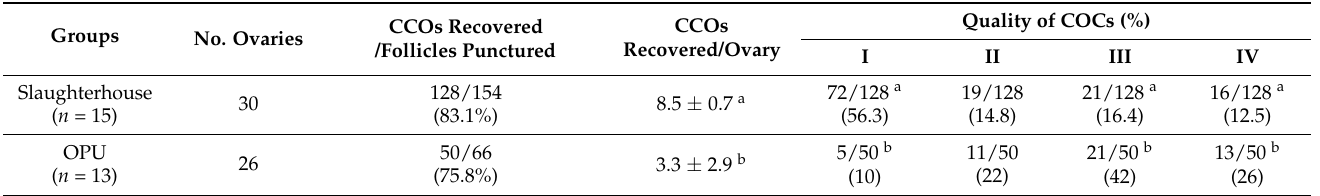
Table 1. Total number of punctured follicles, COCs recovered and quality of oocytes collected from